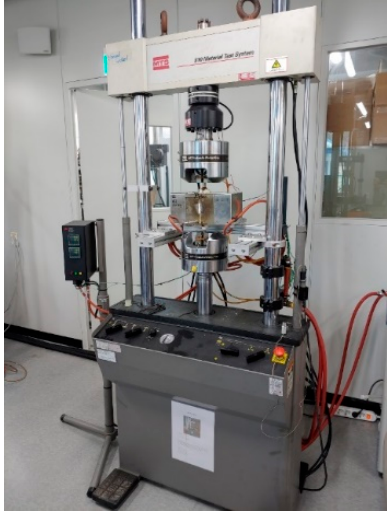
Figure 1. Equipment for tensile tests (MTS-810 material test system).